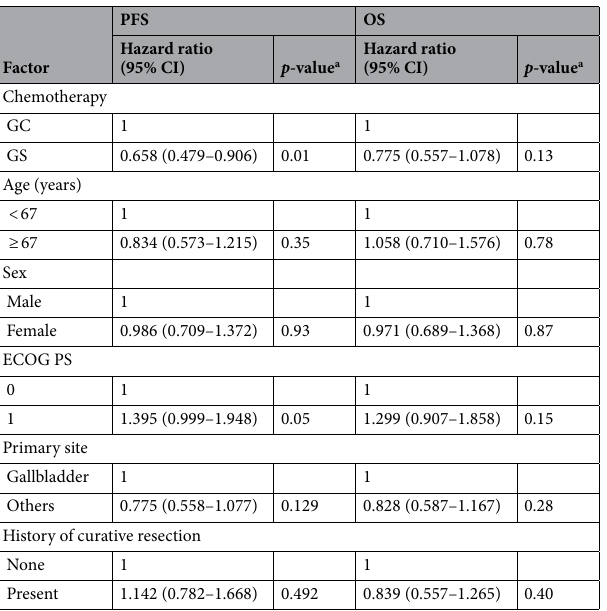
Table 4. Multivariable analysis of clinicopathological factors for PFS and OS in the low CCr group. CCr creatinine clearance, CI confidence interval, ECOG PS Eastern Cooperative Oncology Group